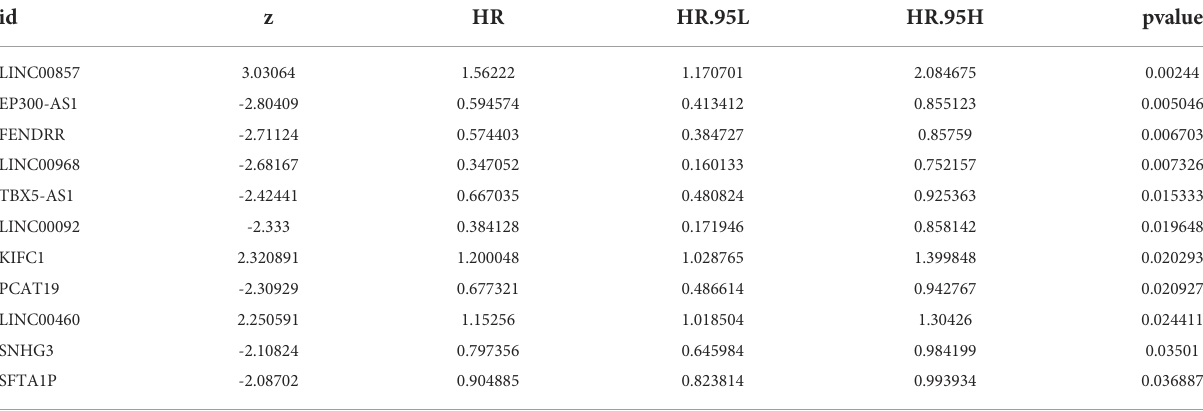
Supplementary Table 4 and Table 5. A 109-protein interaction network was constructed by the STRING (https://string-db.org)